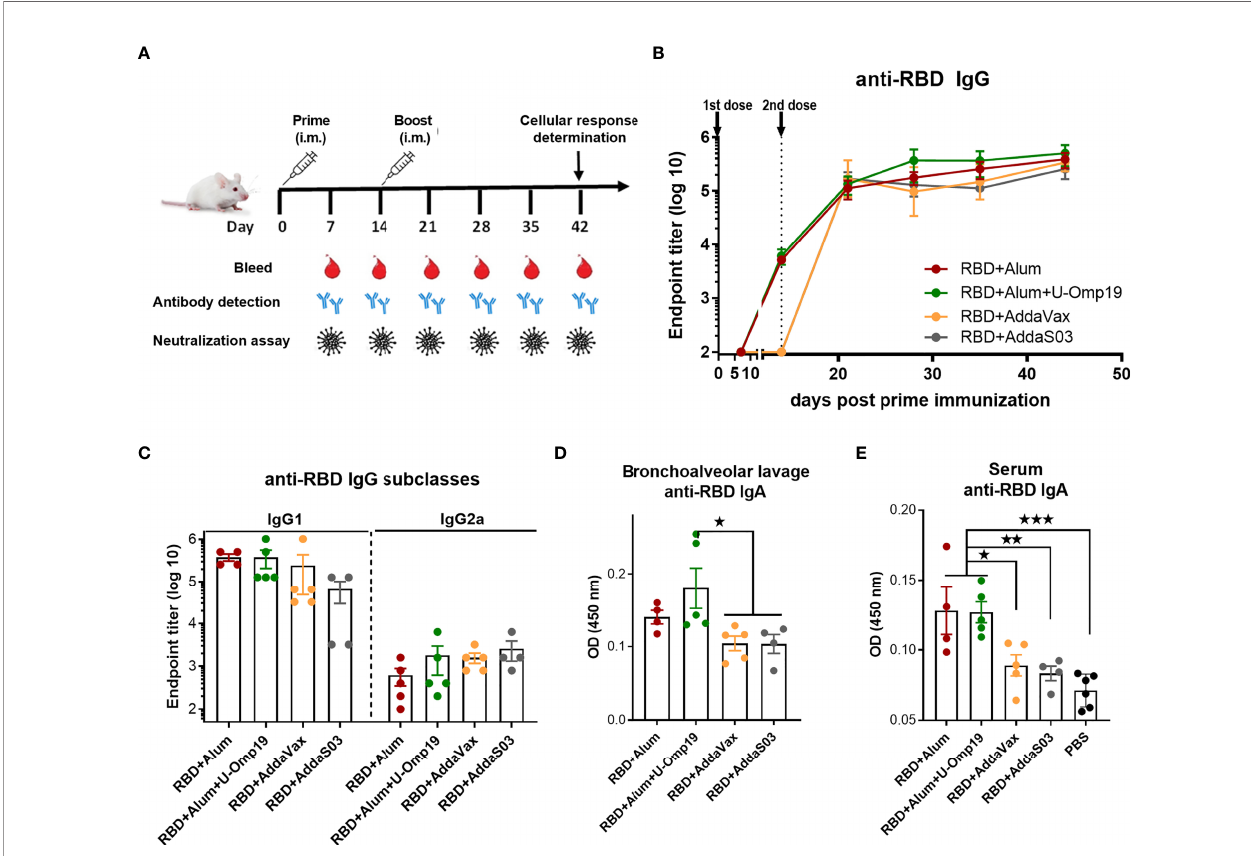
FIGURE 2 | BALB/c mice immunized with RBD plus different adjuvants induced RBD-speci fi c antibodies. (A) Immunization protocol scheme. BALB/c mice were vaccinated at day 0 and day 14 via i.m route with RBD+Alum (n = 5), RBD+Alum+U-Omp19 (n = 5), RBD+AddaVax (n=5), or RBD+AddaS03 (n = 4). Serum samples were obtained at indicated time points for ELISA and neutralization assays. (B) Kinetics of RBD-speci fi c IgG endpoint titers in sera of immunized animals by ELISA. Points are means ± SEM. (C) RBD-speci fi c IgG subclasses (IgG1 and IgG2a) titers in sera of immunized animals at day 44 post prime immunization. Detection of RBD-speci fi c IgA in the bronchoalveolar lavage (D) and serum (E) of immunized mice at day 44 post prime immunization. Samples were diluted at 1/50 for BAL and 1/100 for serum. Data are optical density (OD) at 450 nm. *p < 0.05. **p < 0.01. ***p < 0.001. One-way ANOVA with Bonferroni post-test. Results are representative of two independent